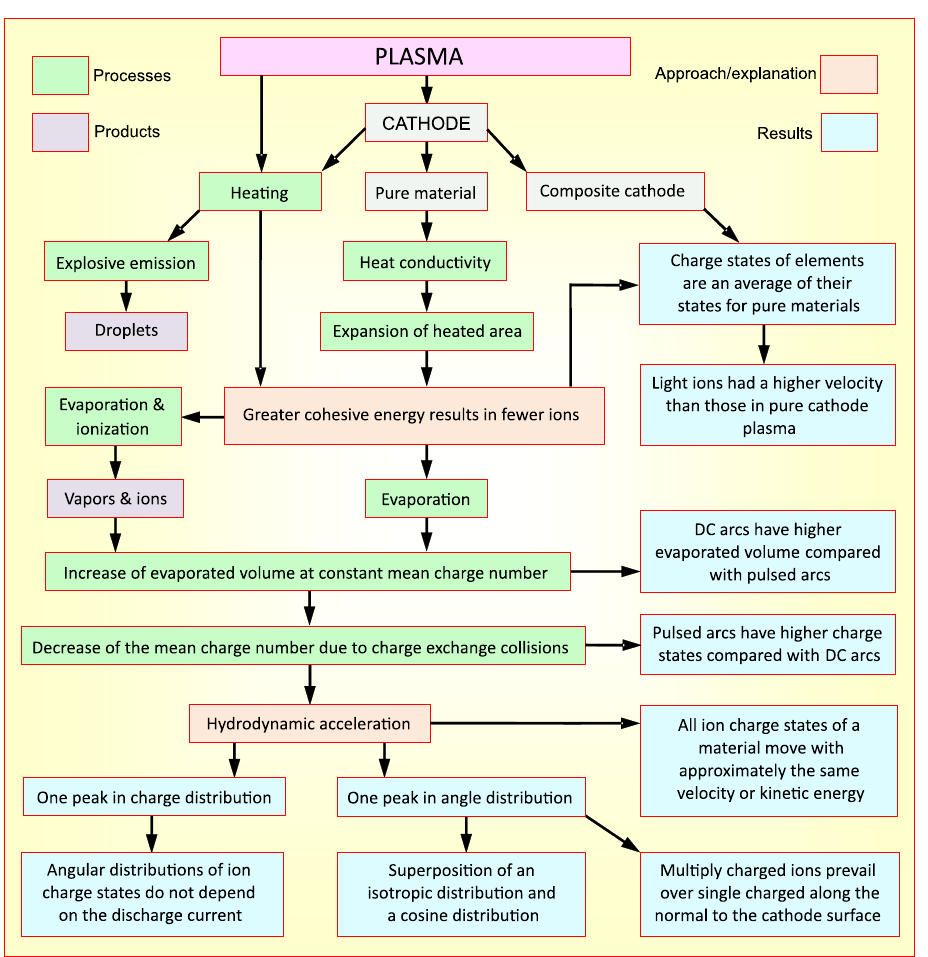
Figure 6. Schematic describing the ablation and ion charge states distribution. For a very simple design of an arc thruster, the whole set of involved physical processes is quite complex. Reproduced with permission from Ref. [26]. Copyright 2019,